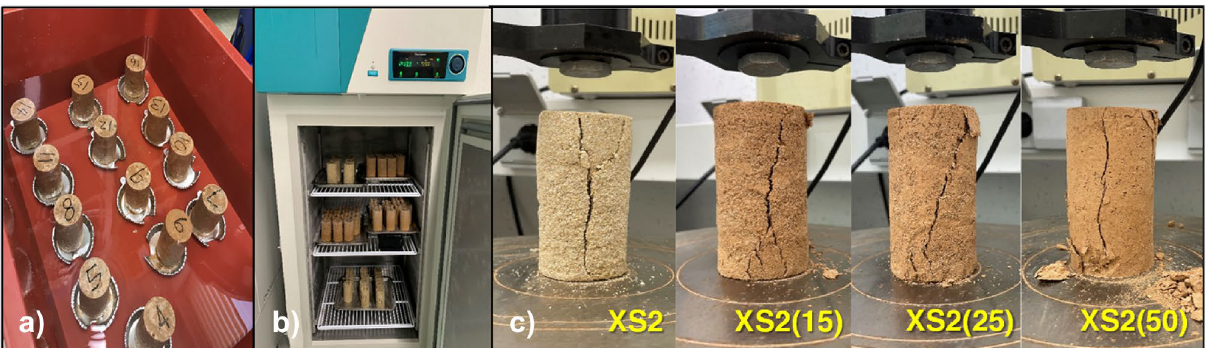
Figure 4. Durability test of biopolymer-treated soil in the laboratory. ( a ) Wetting, ( b ) Freezing (− 20 °C), ( c ) Unconfined compressive strength measurement of XS2, XS2(15), XS2(25), and XS2(50) specimens